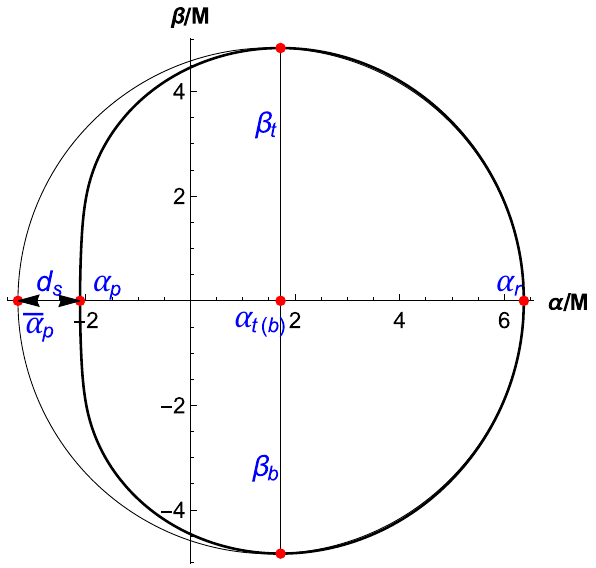
Fig. 9 A sketch of the black hole shadow and the reference circle. The distance between the extreme left point of the shadow, and the reference circle is represented by d